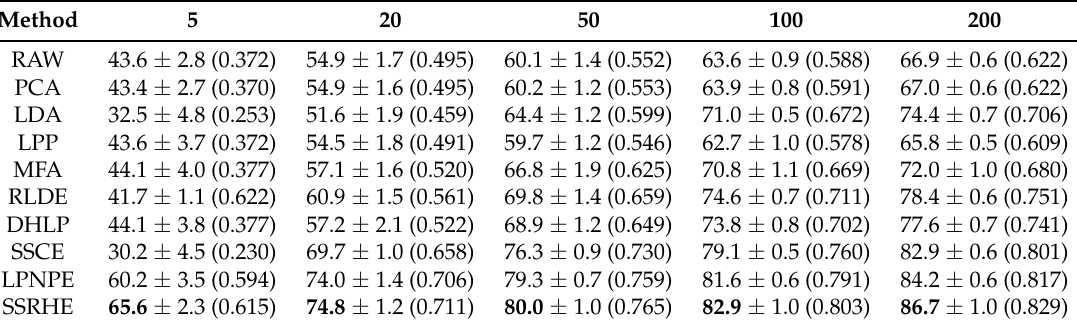
Note that the best results of a row are marked in